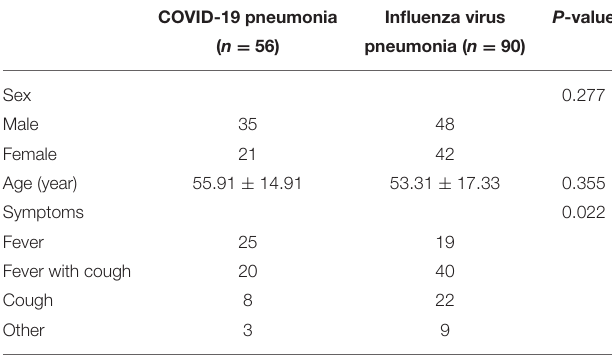
TABLE 1 | Baseline characteristics of